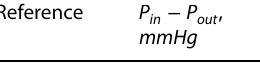
Table 3 The pressure drops straight cylindrical vessel with an idealized stenosis d/D = 0.4, in comparison of the published results